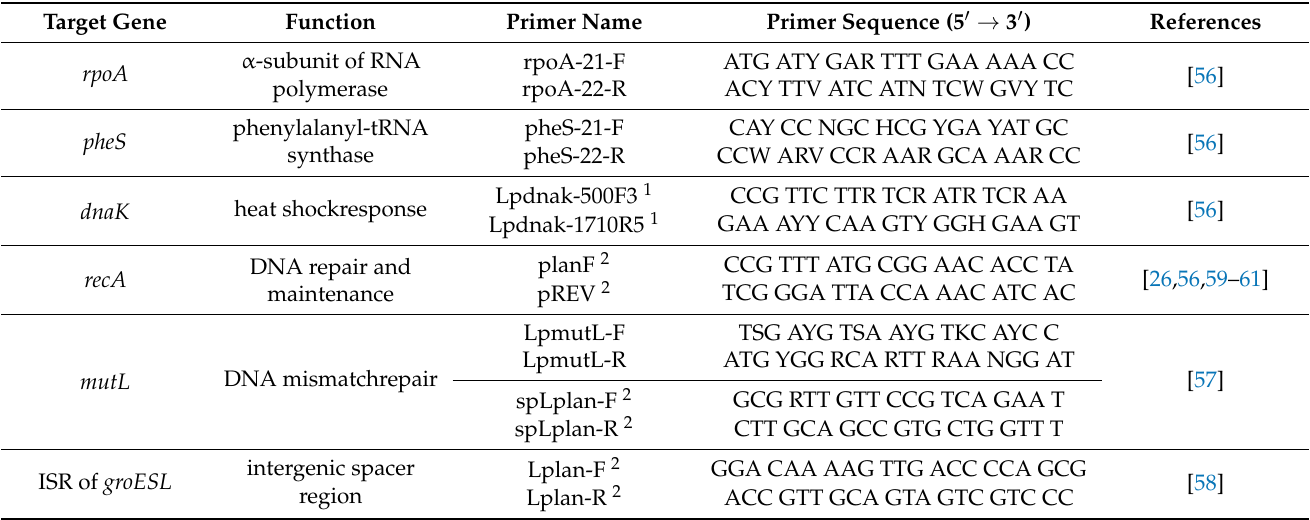
Table 1. Housekeeping genes used for L. plantarum